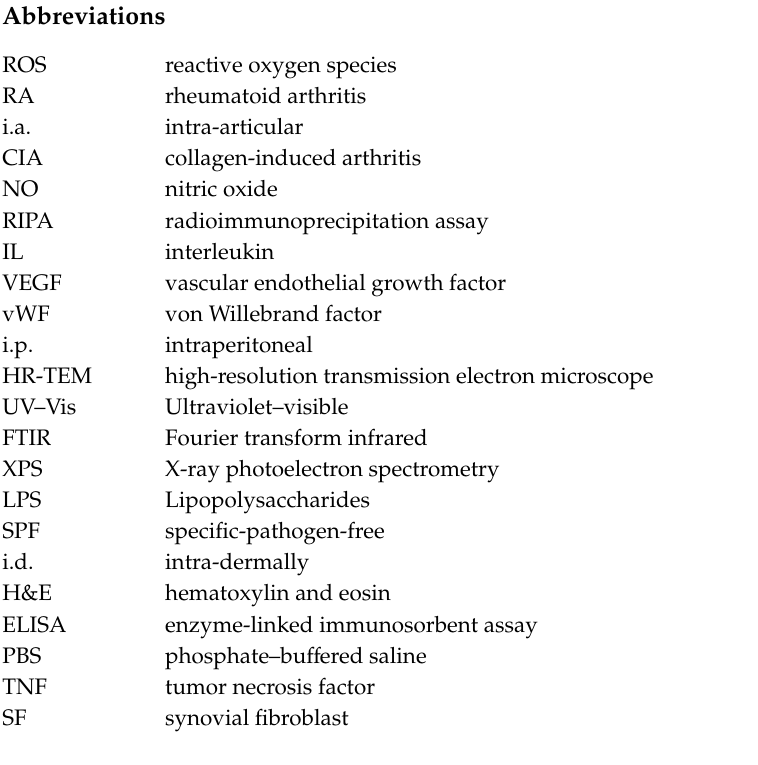
Figure S1: The size of water-soluble C 60 (OH) 36 (fullerenol) was determined by the DLS and the average size was approximately 125.7 nm, which attributed to the hydrogen bond to form the aggregation of